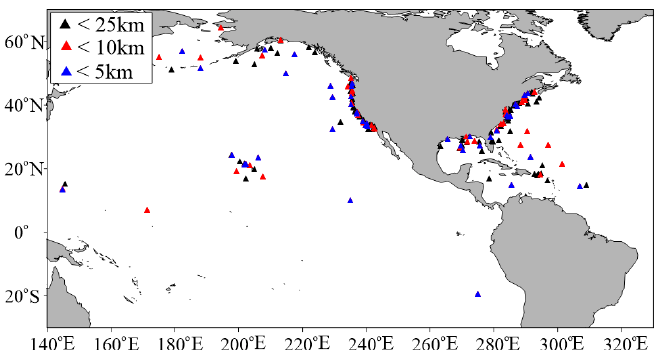
Figure 4. Location of the collocated U. S. National Data Buoy Center (NDBC) buoys with Sentinel-3A.